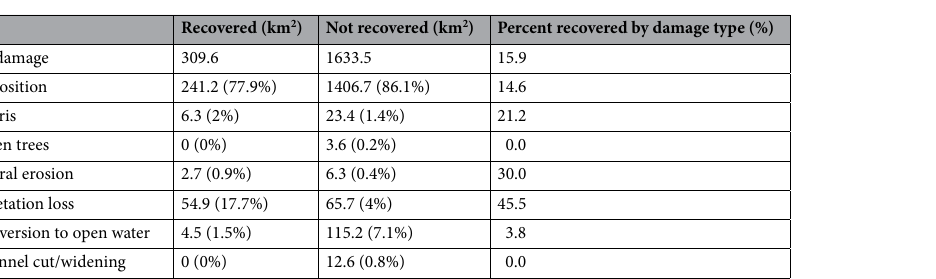
Table 3. Area of marsh recovery study and percent recovered by damage